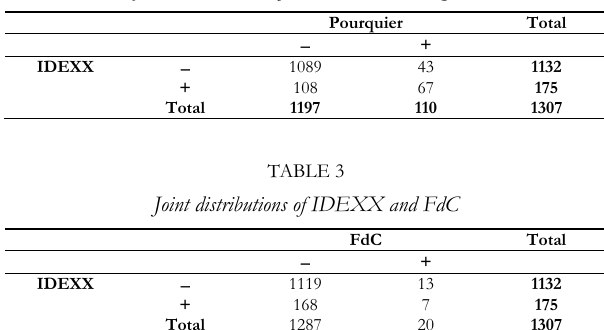
Joint distributions of IDEXX and Pourquier